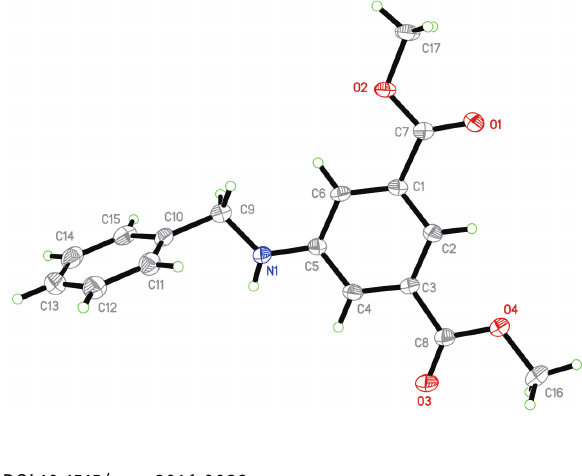
Table 1: Data collection and handling.